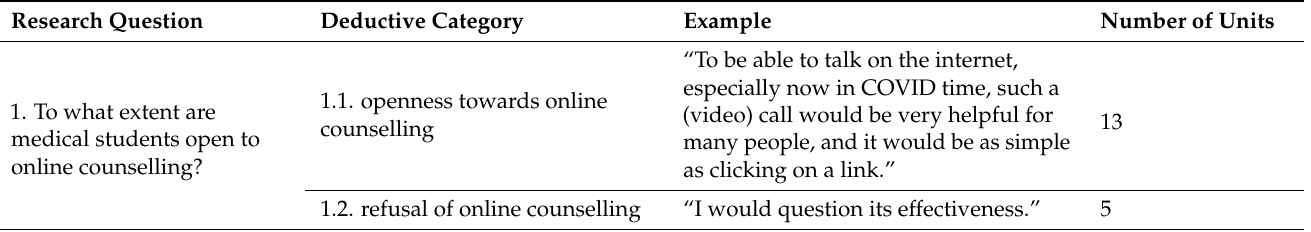
Table A2. The deductive coding scheme of openness and preferences in terms of online